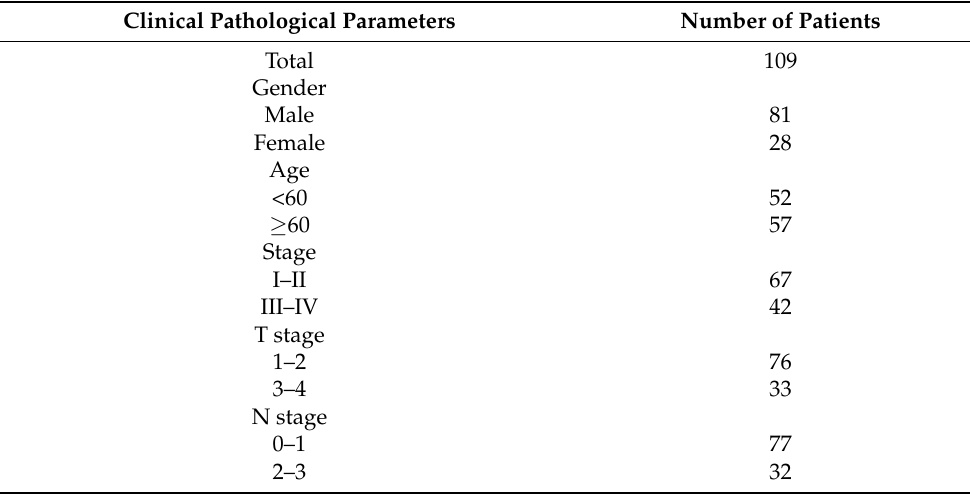
Table 1. The basic clinical pathological information of all